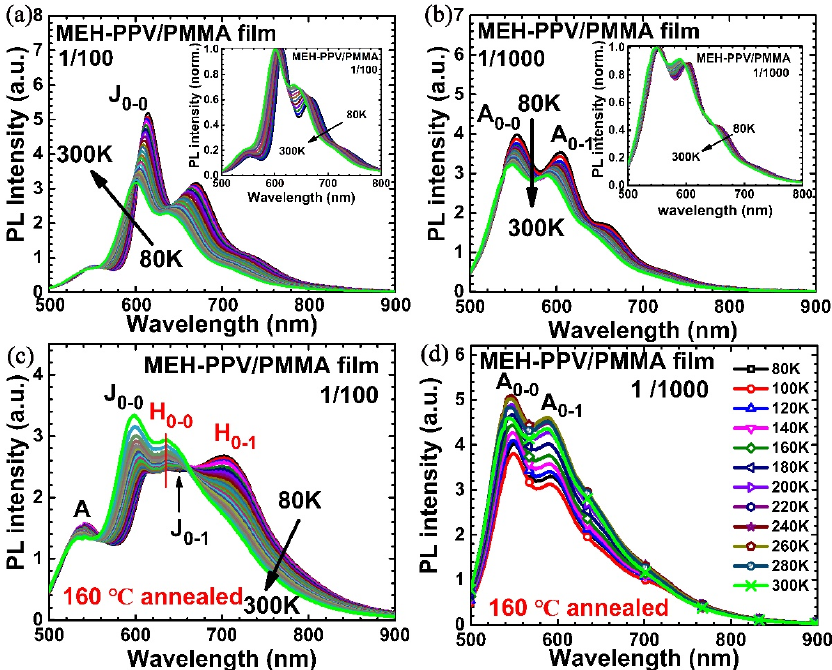
Figure 2. Temperature-dependent photoluminescence spectra of MEH-PPV/PMMA blends ( a ) as-cast film with weight ratio of 1/100 (sample A), ( b ) as-cast film with weight ratio of 1/1000 (sample B), ( c ) film with weight ratio of 1 / 100 (sample A), ( b ) as-cast film with weight ratio of 1 / 1000 (sample B), sample A annealed at 160 °C (1/100), ( d ) sample B annealed at 160 °C (1/1000). The inserts in ( a ) and ( c ) sample A annealed at 160 ◦ C (1 / 100), ( d ) sample B annealed at 160 ◦ C (1 / 1000). The inserts in ( a , b ) are ( b ) are the respective normalized spectra. the respective normalized